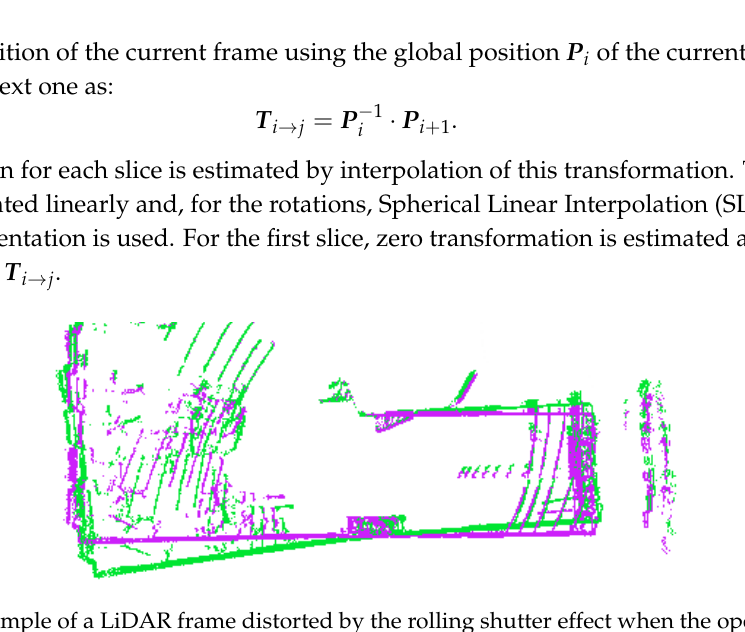
Figure 14. Example of a LiDAR frame distorted by the rolling shutter effect when the operator with mapping backpack was turning around (green) and the corrected frame (purple). This is the top view and the distortion is mostly visible on the “bent” green wall at the bottom of this picture.